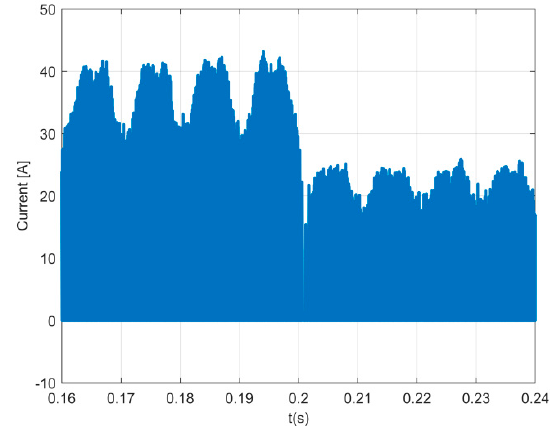
Figure 10. Results of the DC output current in transient conditions (i o1 ).